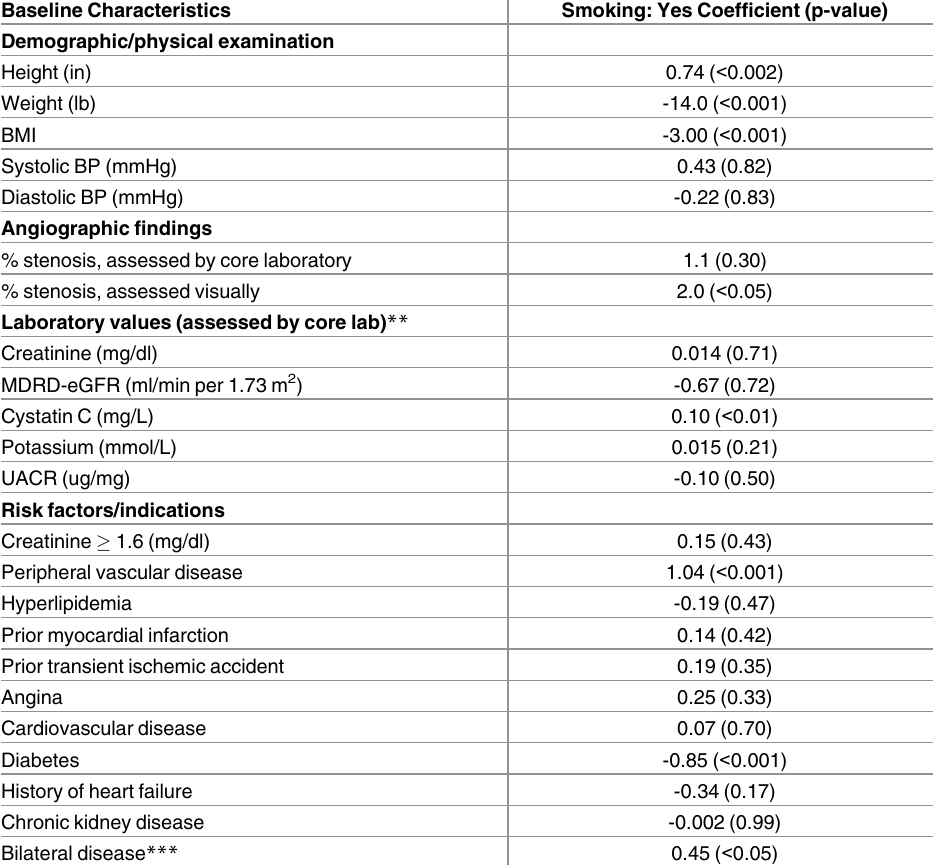
Table 2. Multivariate linear regression and generalized linear regression comparing smokersand non-smokers on baseline characteristics as the response adjusted for age, sex and ethnicity. Baseline